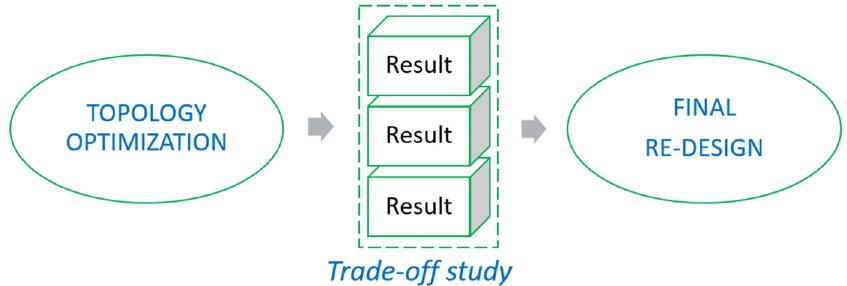
Figure 2. Systematic concept selection-based approach for product optimisation.